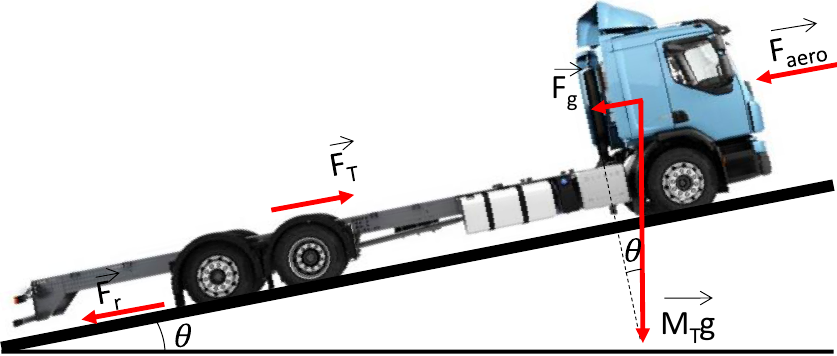
The vehicle forces are calculated following the energy balance equation presented in